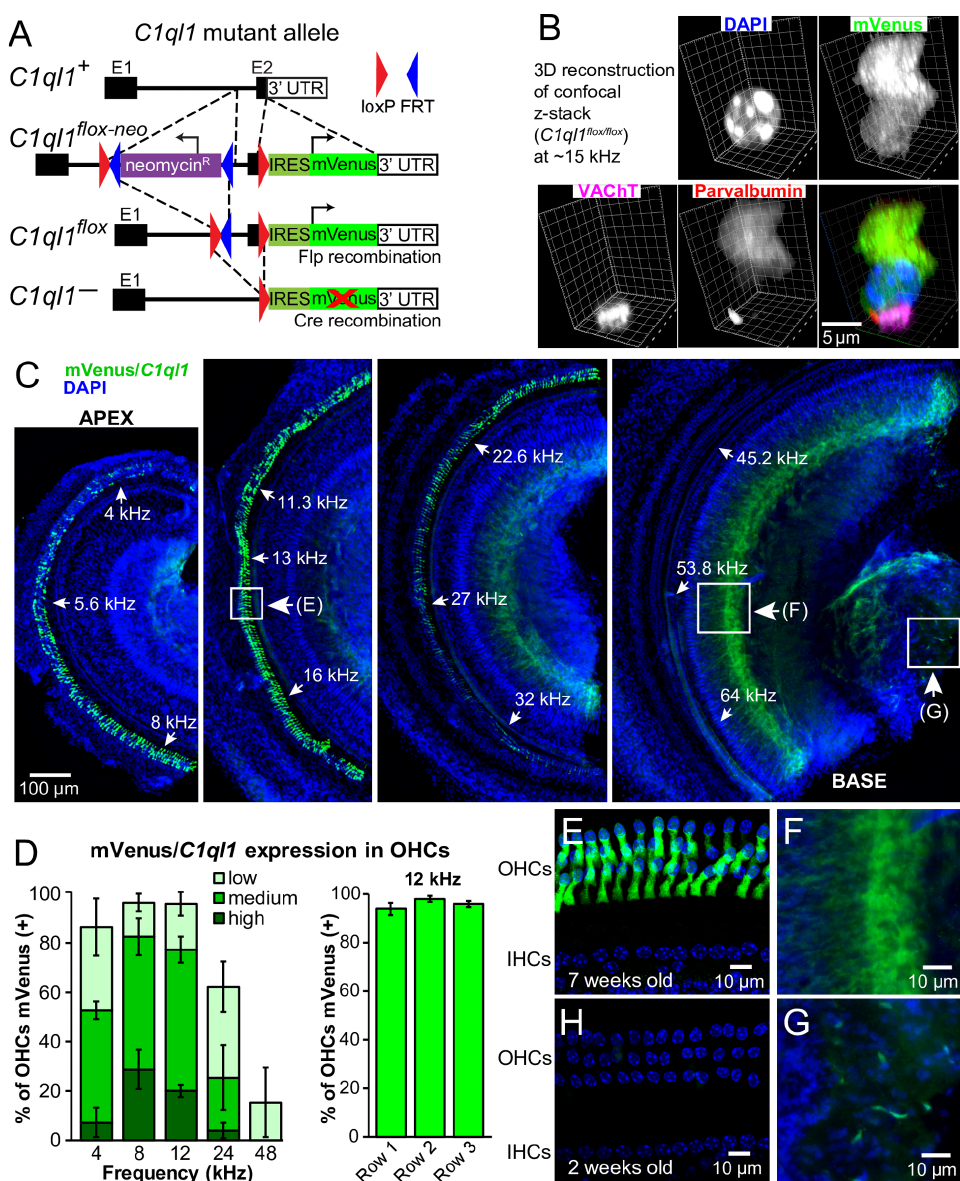
Fig 2. C1ql1 is expressed by OHCs. (A) Targeting scheme for conditional C1ql1 -mVenus mutant allele. E1 = exon 1; E2 = exon 2. The red X indicates that after Cre-mediated recombination, mVenus protein is not made due to degradation of the mRNA. All experiments in this manuscript use the version of the allele after Flp-mediated recombination. (B) 3D confocal fluorescence image of a single mVenus-positive OHC from the ~15 kHz region of the organ of Corti from a C1ql1 flox/flox mouse. Immunofluorescence for parvalbumin marks the post-synaptic side of the afferent synapse, VAChT marks the pre-synaptic side of the efferent synapse, and DAPI marks the nucleus. The signal intensity of mVenus from the C1ql1 flox allele was low so an anti-GFP antibody was used to enhance the signal. (C) Representative entire organ of Corti from a 7-week-old C1ql1 flox/flox mouse imaged with a widefield fluorescence microscope. (D) Quantification of frequency regions of OHCs that express C1ql1 /mVenus. Left: OHCs at 5 representative frequency locations were measured for mVenus fluorescence intensity and categorized as having high, medium, low, or zero signal. N = 5 mice; error bars are standard deviation. Right: the presence of any mVenus was quantified in each of the 3 OHC rows. The representative frequency region of 12 kHz is shown. No differences were noted at any location along the tonotopic gradient. (E) Magnified view of a boxed region in panel C. (F) Magnified view of a boxed region in panel C. (G) Magnified view of a boxed region in panel C. (H) Representative image from a 2-week- old C1ql1 flox/flox mouse taken at similar frequency location as panel